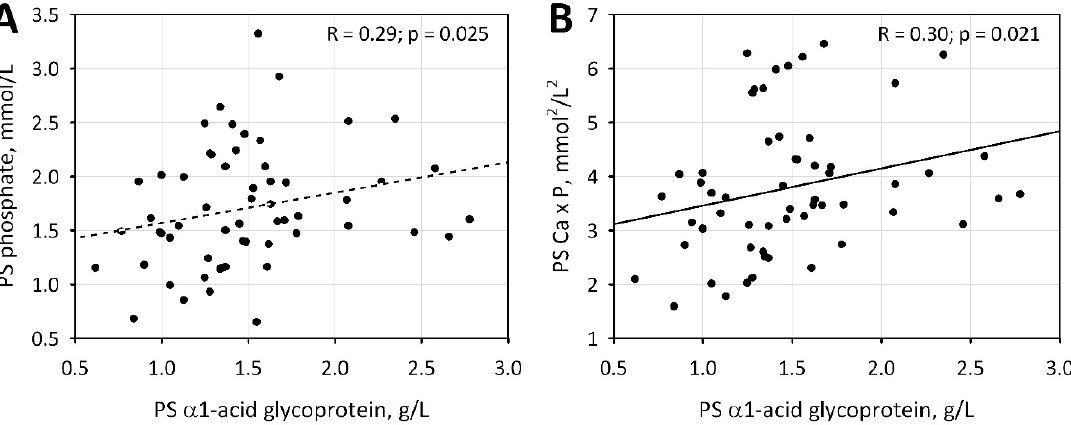
Figure 3. Correlations between α 1- acid glycoprotein concentration and phosphate level ( A ) and Ca × P value ( B ) in the post-summer period.